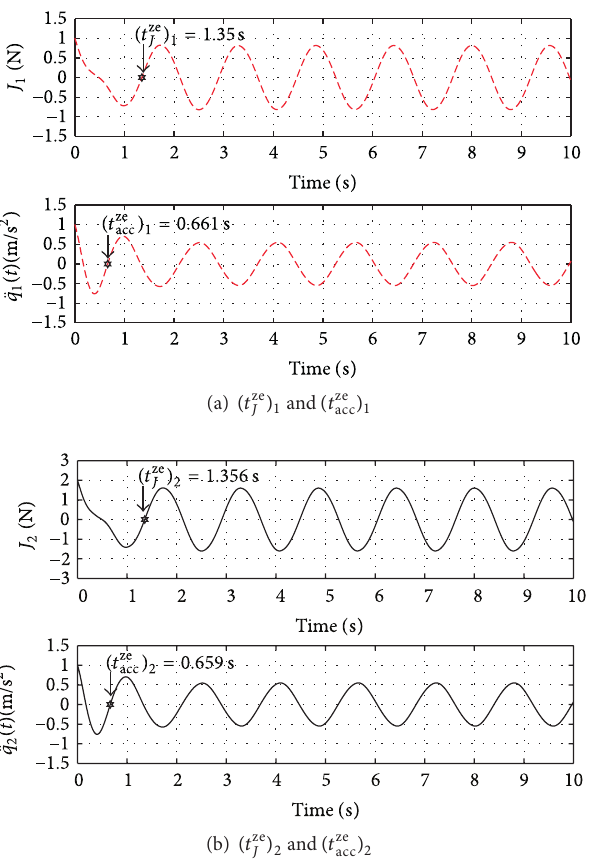
Figure5:Illustrationofzero-crossingtimes: (𝑡 ze 𝐽 ) 𝑖 fromthetransient ) region and (𝑡 ze 𝑖 from the steady-state region ( acc